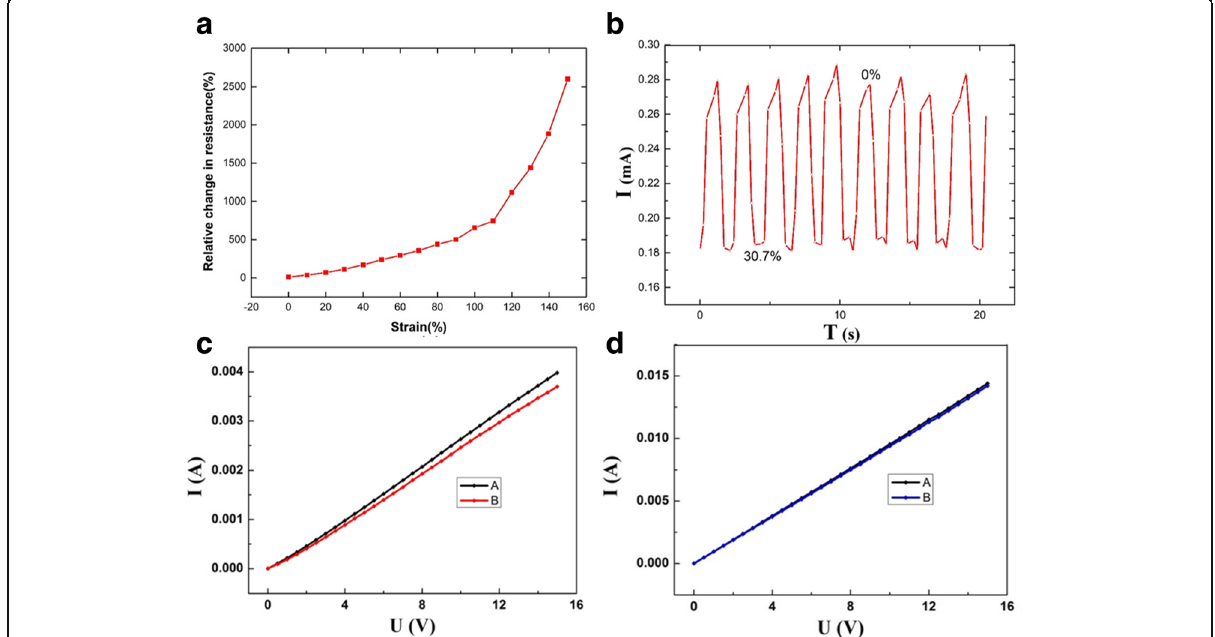
Fig. 6 Stability and durability test of the PANI/TPU membrane sensor. a Relative changes in resistance of the PANI/TPU membrane sensor under different strains. b Stability test under a fixed strain of 30.7%. c A is the I - V curve at the initial stage, and B is the I - V curve after 100 times stretching to 30.7% and placed for 24 h. d A is the I - V curve at the initial stage, and B is the I - V curve after 1000 times bending and placed for 24